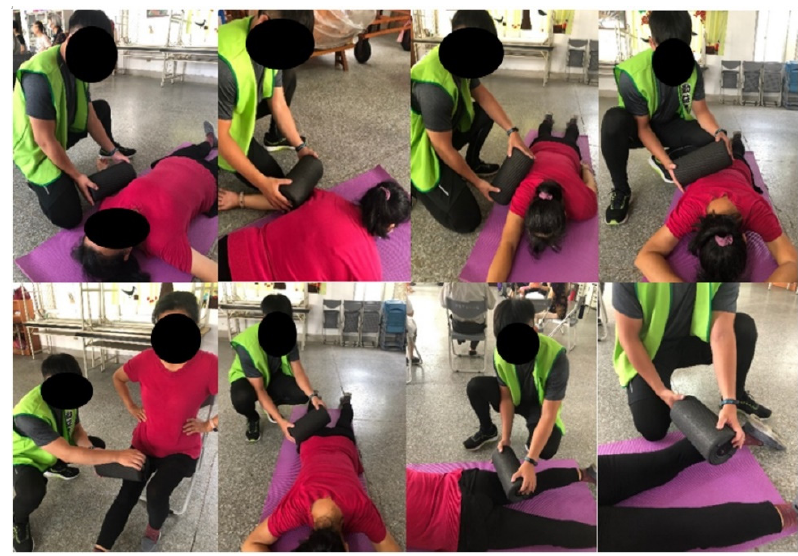
Figure 3. The demonstration of the vibration rolling protocols .